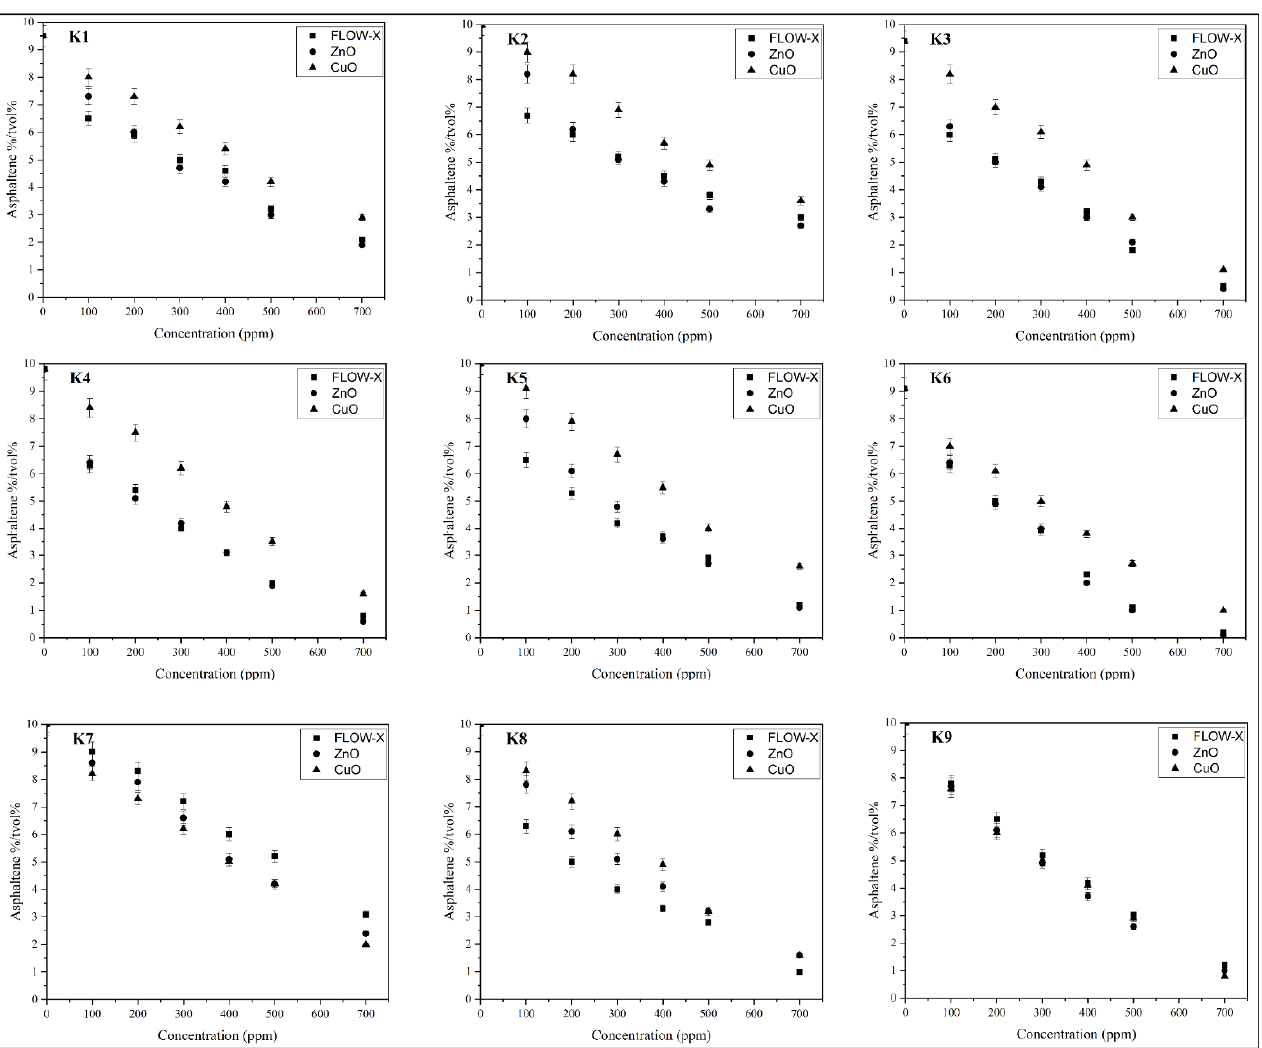
Figure 9. ADT results of K1, K2, and K3 – K9